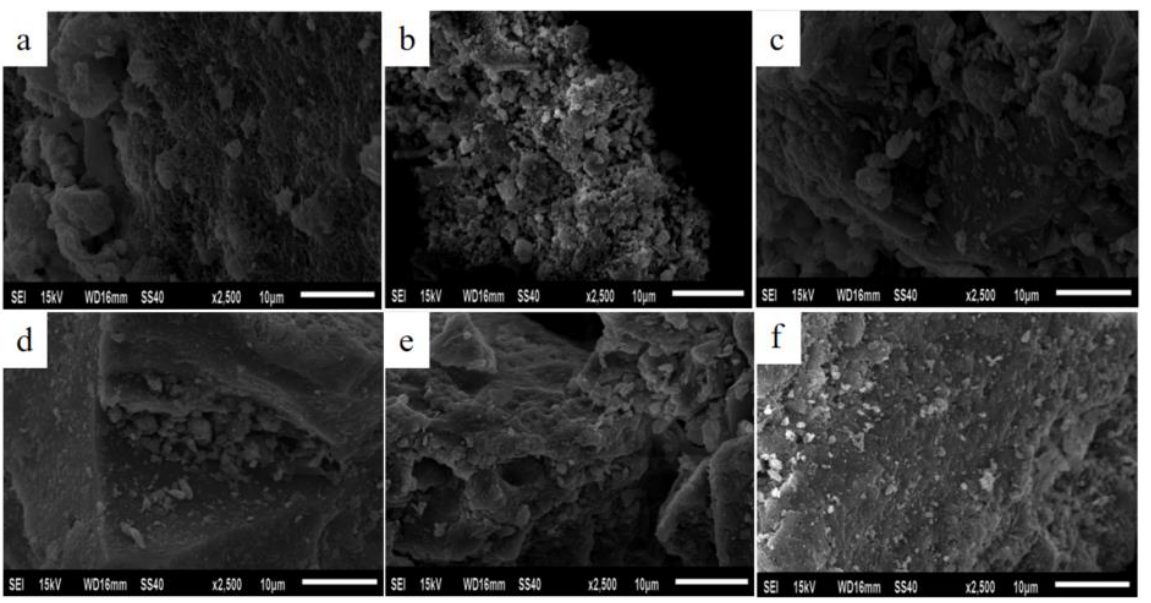
Figure 3. Scanning electron microscopic analysis of zeolite: ( a ) NaOH-modified zeolite, ( b ) Na 2 S- modified zeolite, ( c ) high temperature-modified zeolite, ( d ) humic acid-modified zeolite, ( e ) ultrasonic-modified zeolite, and ( f ) natural zeolite.